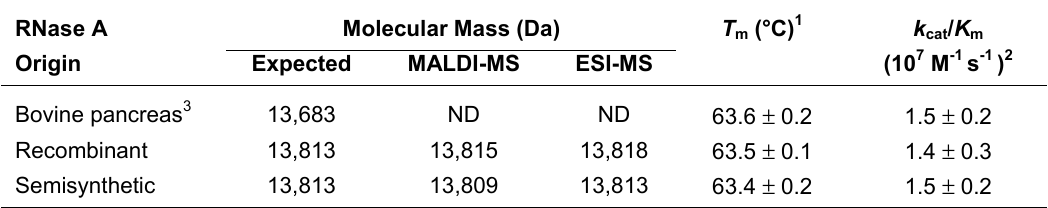
Properties of RNase A Produced by Three Distinct Methods RNase